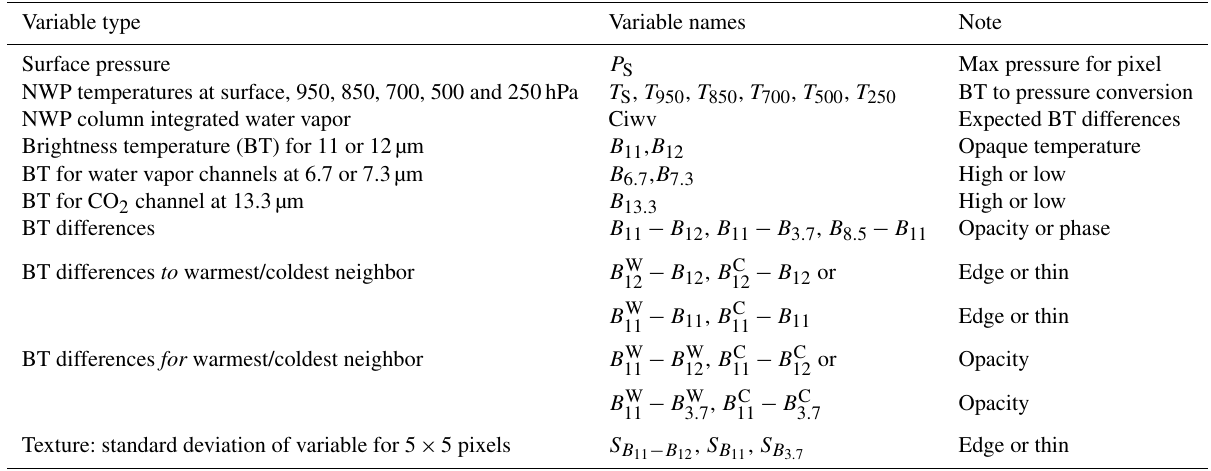
Table 2. Description of variable types used to train the neural networks.